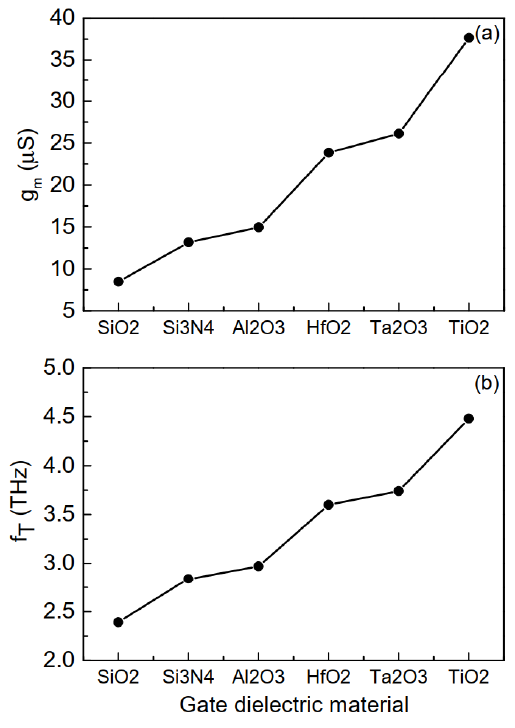
Figure 13. Behavior of ( a ) transconductance and ( b ) cut-off frequency with different high-k gate dielectric materials at V ds = 0.05 V.